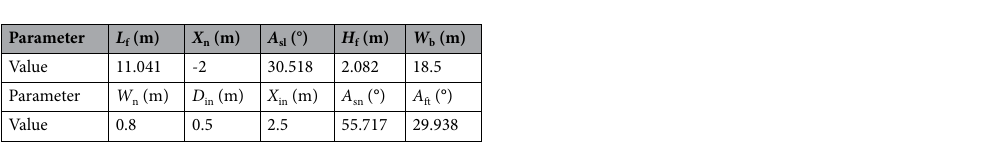
Table 1. The main geometric size data of m 0